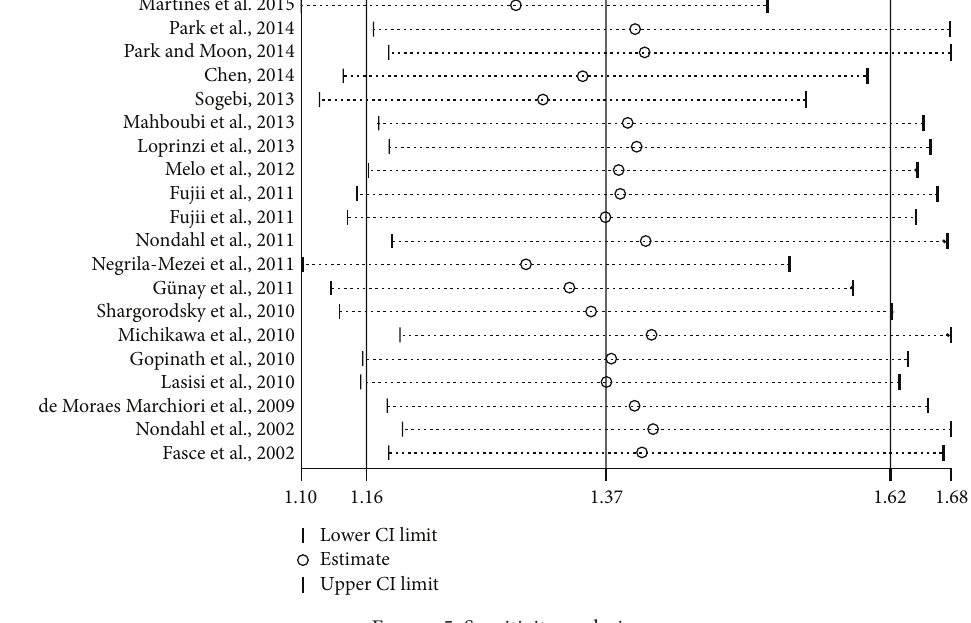
Figure 5: Sensitivity